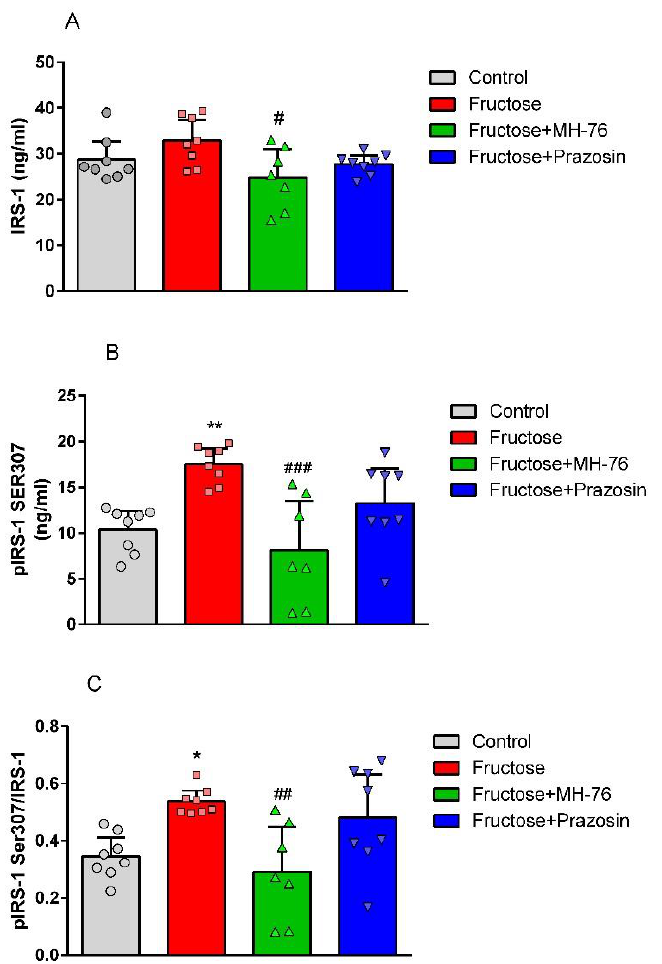
Figure 3. Effects of MH-76 (5 mg/kg i.p.) and prazosin (0.2 mg/kg i.p.) on ( A ) IRS-1 and ( B ) pIRS-1 Ser307 concentration in fructose-fed rats adipose tissue. ( C ) Ratio of pIRS-1 Ser307 to IRS-1 concentration in different experimental groups. Data are expressed as means ± Δ/2, where Δ is a width of the 95% CI, (n = 7–8), * p < 0.05, ** p < 0.01 vs. Control, # p < 0.05, ## p < 0.01, ### p < 0.001 vs. Fructose group (one-way ANOVA, post hoc Bonferroni multiple comparisons test).